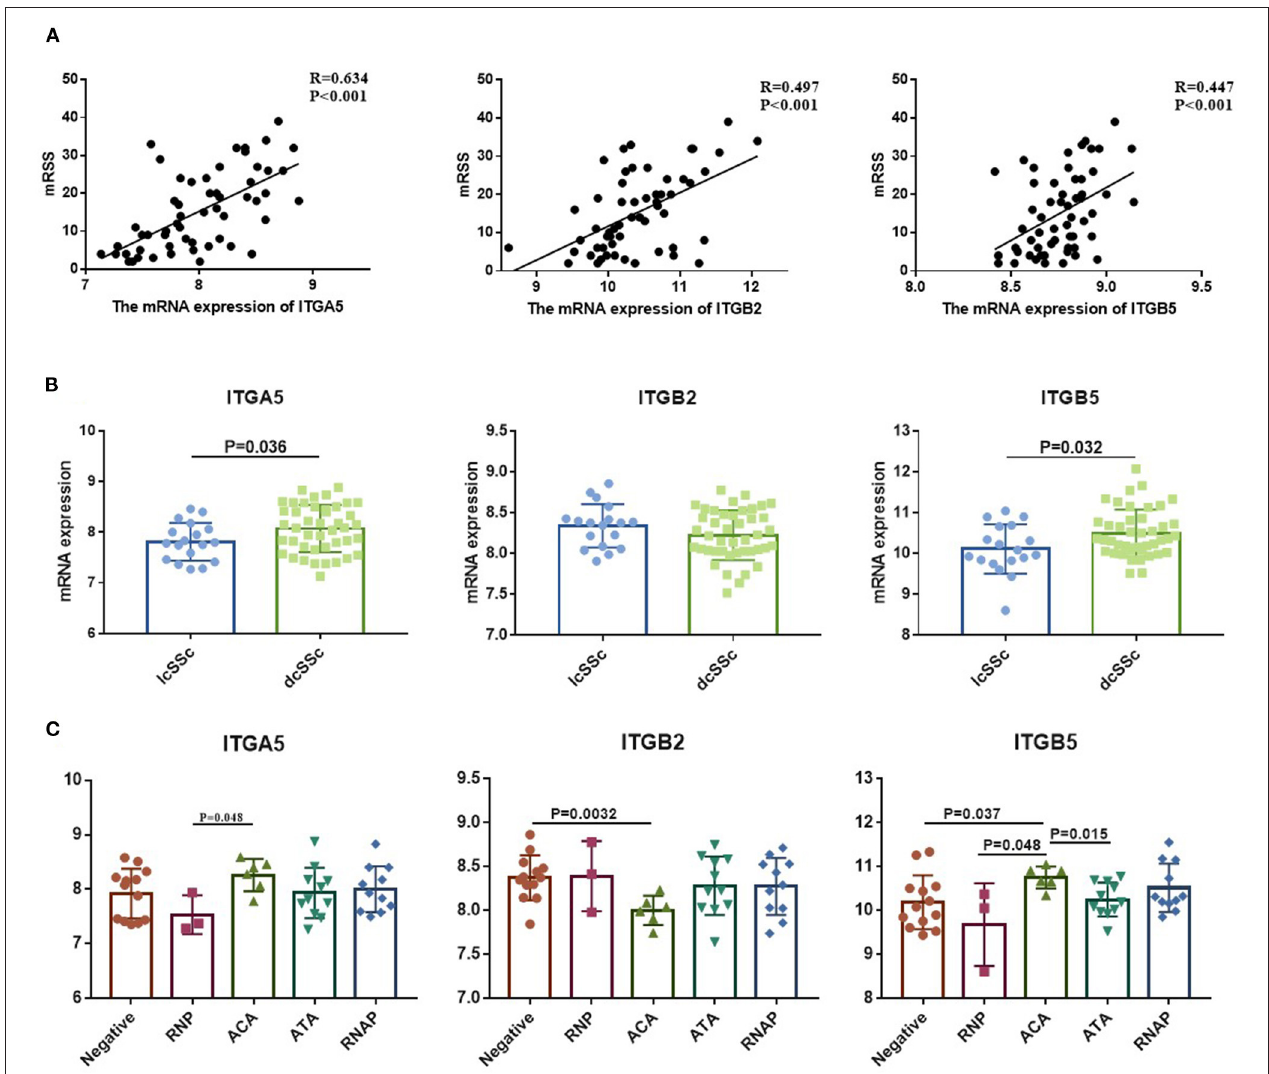
FIGURE 3 | Correlation between aberrant expressed integrin family genes and clinical features of SSc from GSE58095. (A) The mRNA expression of ITGA5 , ITGB2 , and ITGB5 genes was positively correlated with mRSS, respectively. (B) The mRNA expression levels of ITGA5 and ITGB5 were higher in dcSSc than in lcSSc. (C) ITGB2 was downregulated in patients seropositive for ACA than in lacking specific antibodies. The gene expression of ITGB5 was higher in patients seropositive for ACA than in those lacking specific antibodies or those seropositive for either RNP or ATA. SSc, systemic sclerosis; dcSSc, diffused cutaneous systemic sclerosis; lcSSc, limited cutaneous systemic sclerosis; mRSS, modified Rodnan skin thickness score; RNP, anti-U1 RNP antibody; ACA, anti-centromere antibody; ATA, anti-topoisomerase antibody; RNAP, anti-RNA polymerase III